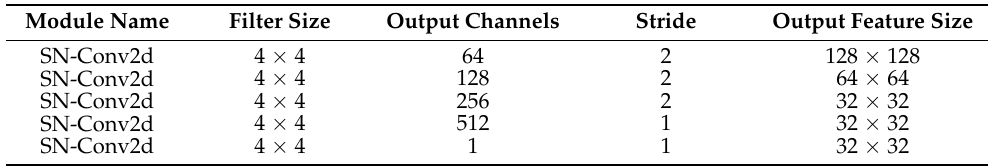
Table A2. Details of the PatchGAN discriminator. “SN-Conv2d” denotes a 2D convolution operator with spectral normalization. " × " denotes